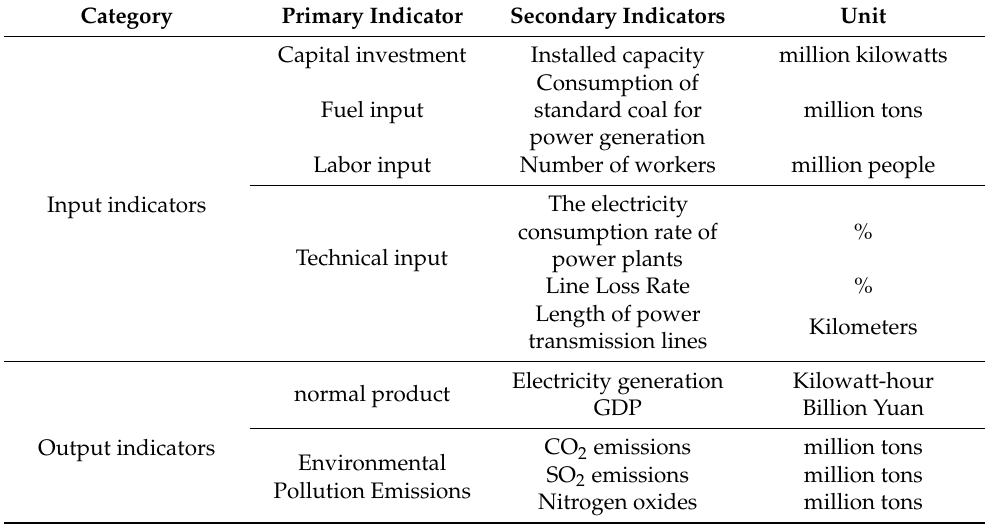
Table 1. Construction of the environmental performance index system in the power